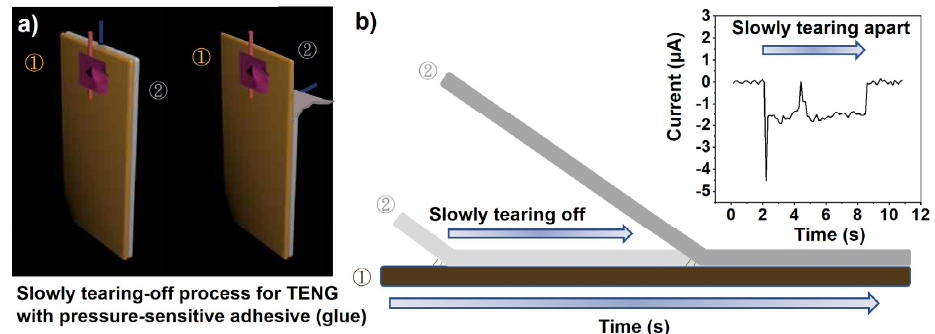
Figure 7. ( a ) Three-dimensional models and ( b ) a schematic showing the separation process of two triboelectric parts (i.e., ① and ② ). The TENG has a triboelectric interface formed by the pressure sensitive adhesive. The inset of ( b ) shows the output current of the TENG during this process.